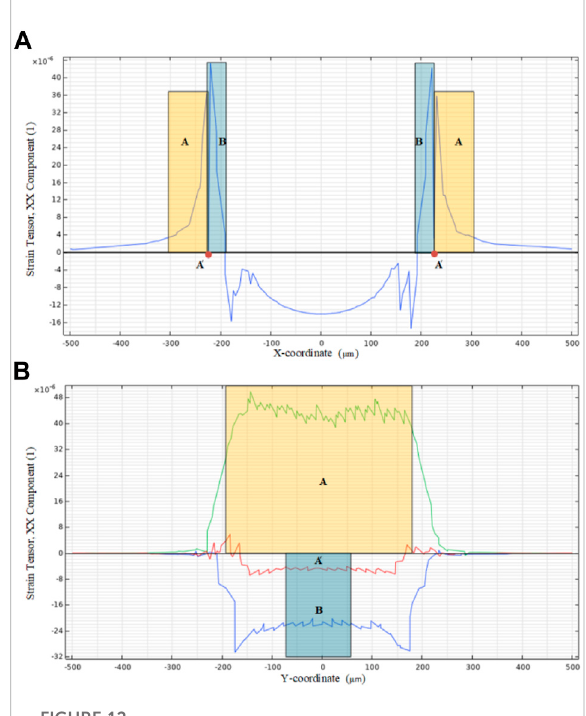
FIGURE 12 Strain tensors along the X -axis (A) and along the Y -axis (B) .